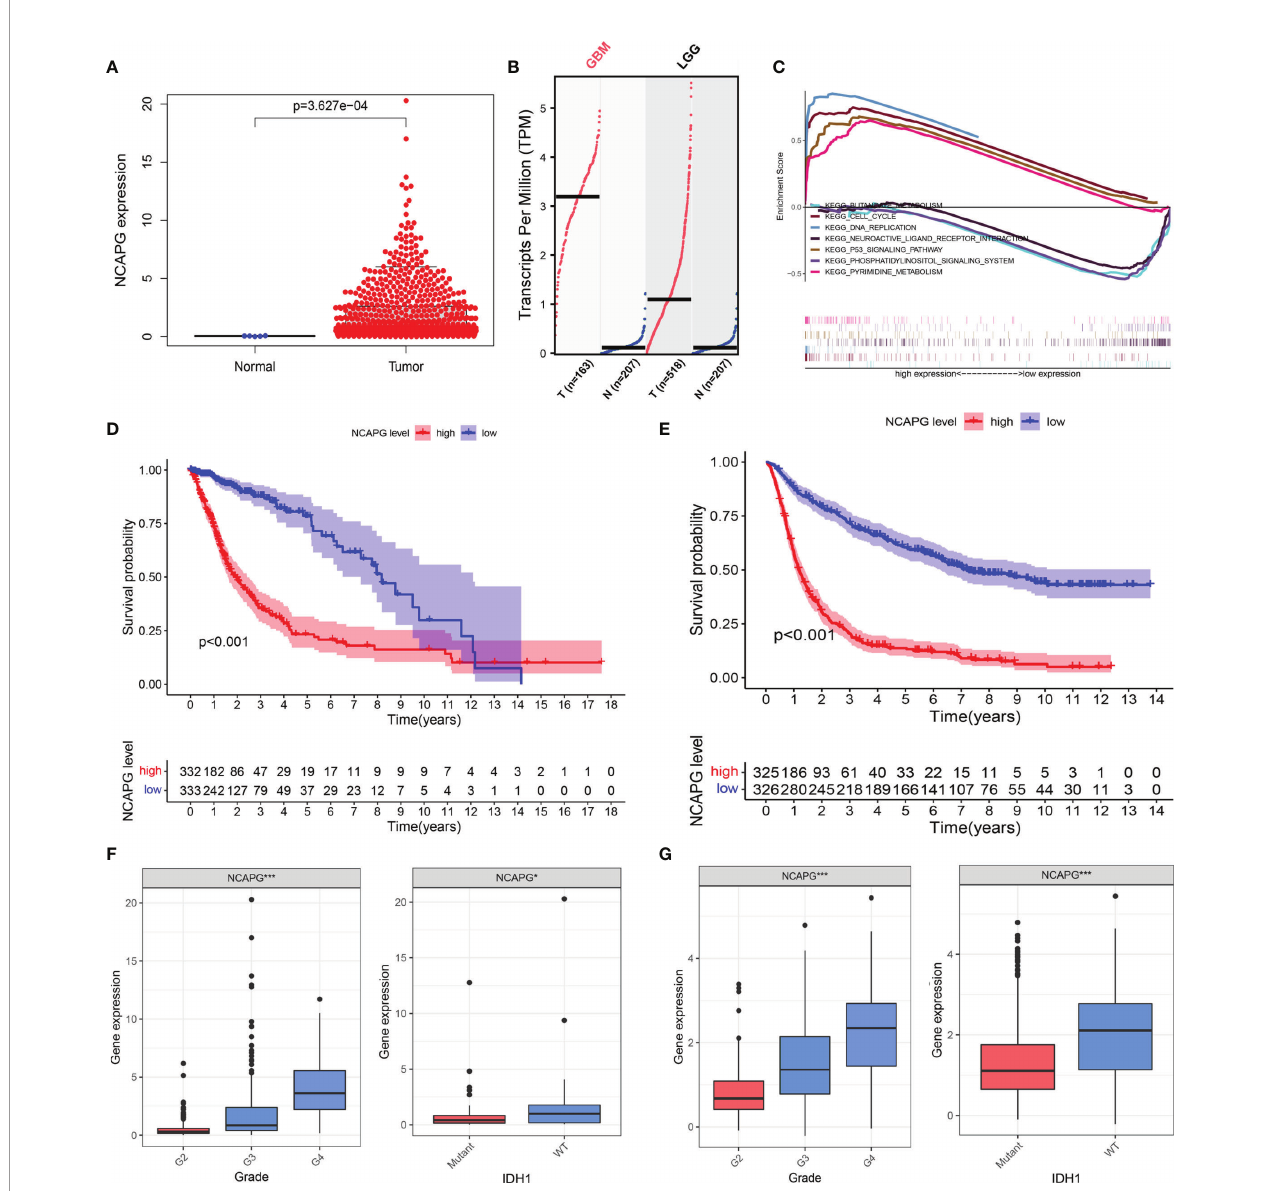
FIGURE 2 | NCAPG is highly expressed in glioma tissues and could be a biomarker for glioma. (A) NCAPG is highly expressed in glioma tissue compared with normal tissue. (B) The expression of NCAPG in high-grade glioma tissues (GBM) and low-grade glioma tissues (LGG) analyzed by GEPIA. (C) Signi fi cantly enriched pathways associated with NCAPG by gene set enrichment analysis (GSEA). (D, E) Survival curve of NCAPG expression in TCGA and CGGA, respectively. (F, G) Differential expression of NCAPG in different cancer grades and isocitrate dehydrogenase (IDH) mutations. (*P < 0.05, ***P <